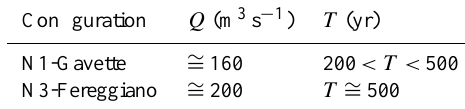
Table 3. Return period of the peak flows simulated for Fereggiano brook using the two different rainfall inputs to feed the hydrological